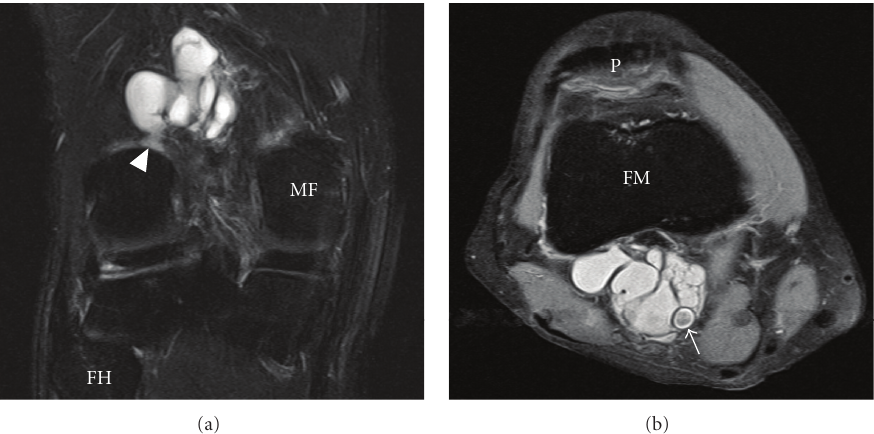
Figure 4: Cluster of communicating extra capsular synovial cysts at the dorsal aspect of the femoral metaphysis. (a) Coronal fat-saturated T2 and (b) axial proton density fat-saturated MR images of the right knee without e ff usion in a 51-year-old male floor layer. The lesion takes it origin from the intracapsular synovial recess at the dorsal cranial aspect of the lateral femoral condyle through a defect in the capsule (arrow head). The majority of these lesions detected in floor layers originated similarly but from the medial femoral condyle. FH, fibular head; MF, medial femoral condyle; FM, femoral metaphysis; P, patella; arrow, popliteal artery. Table 1: Characteristics of the study sample, floor layers ( n = 92), and graphic designers ( n = 49). Floor